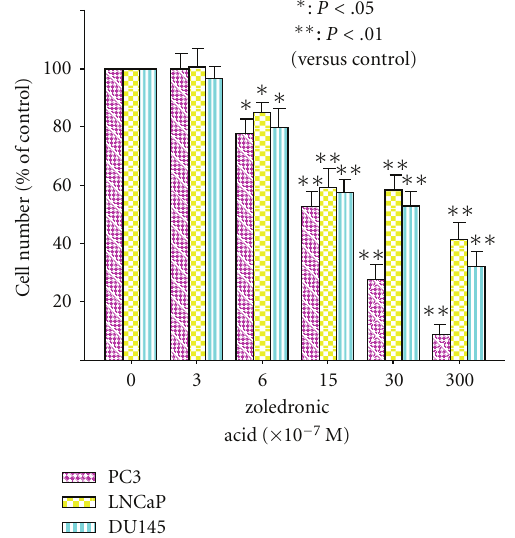
Figure 1: Growth inhibitory e ff ect by Zol. Cells were incubated in the presence of Zol for 72 h, and the cell number was determined. The cell number counted in the vehicle control was defined as being equal to